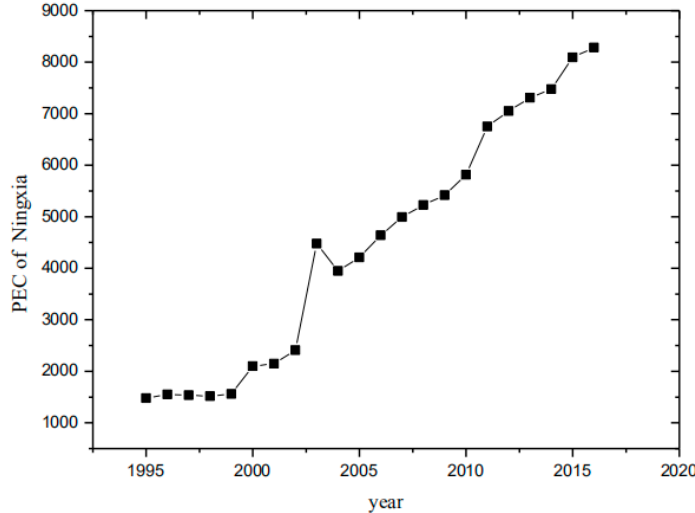
Figure 1. The per capita energy consumption data of Ningxia (kce/person).